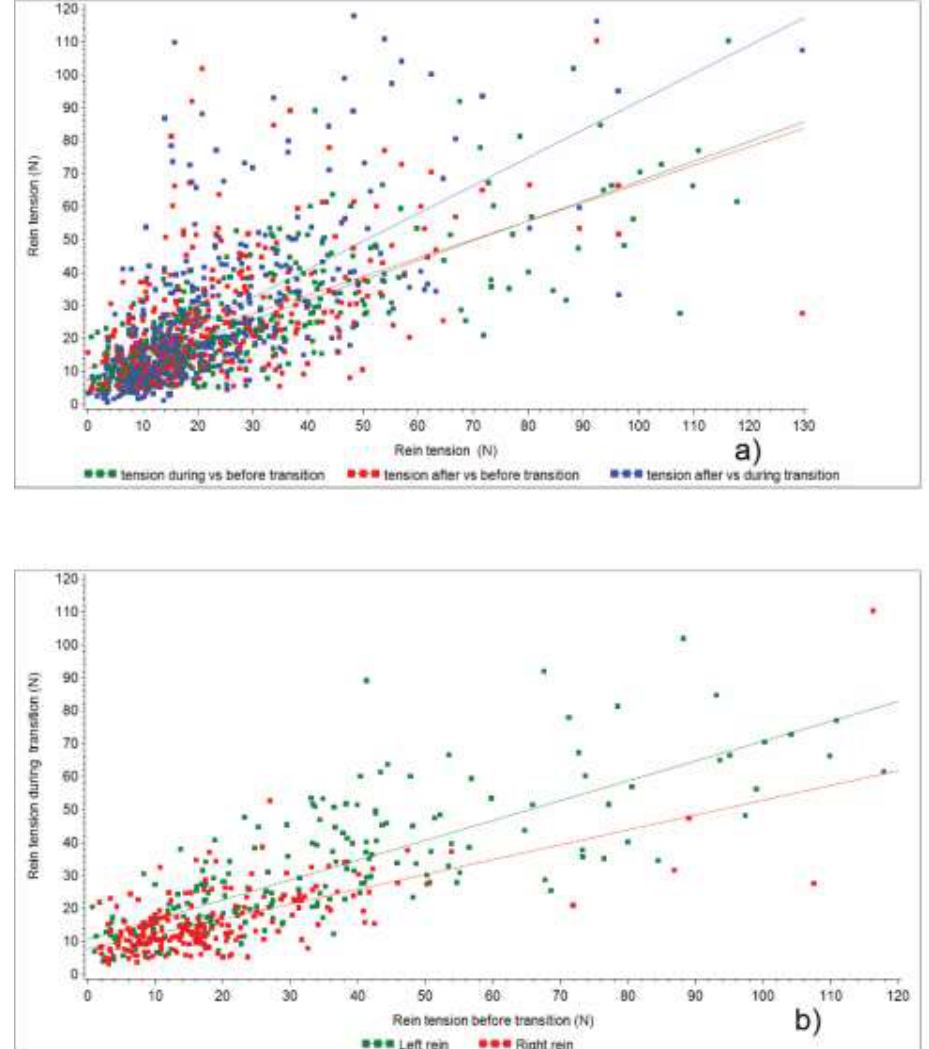
Figure 3. Median rein tension: ( a ) for left and right reins averaged, before, during and after transitions, and ( b ) median left and right rein tension before and during downwards transitions and upwards transitions. The fitted lines go with the symbols of the same colour, n = 427 in both plots.